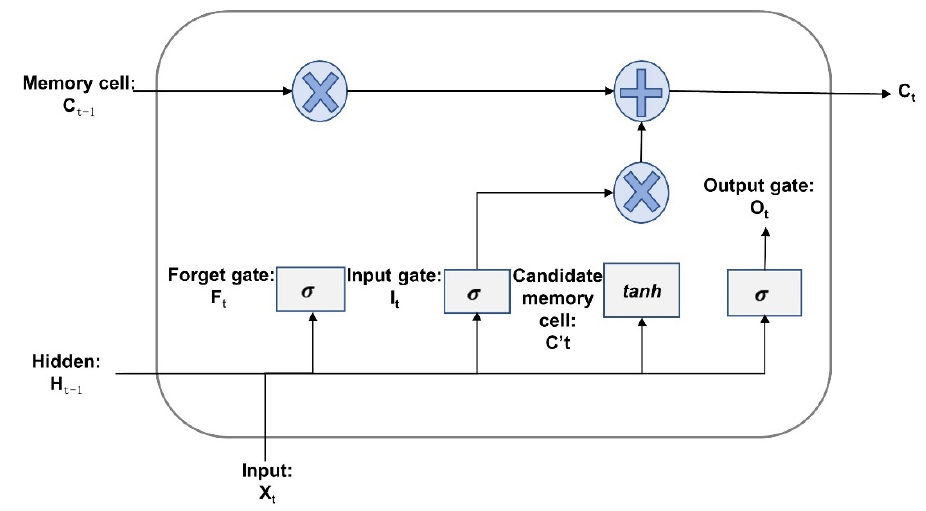
Figure 4. Structure diagram of LSTM CELL, including forget gate, input gate, and output gate.